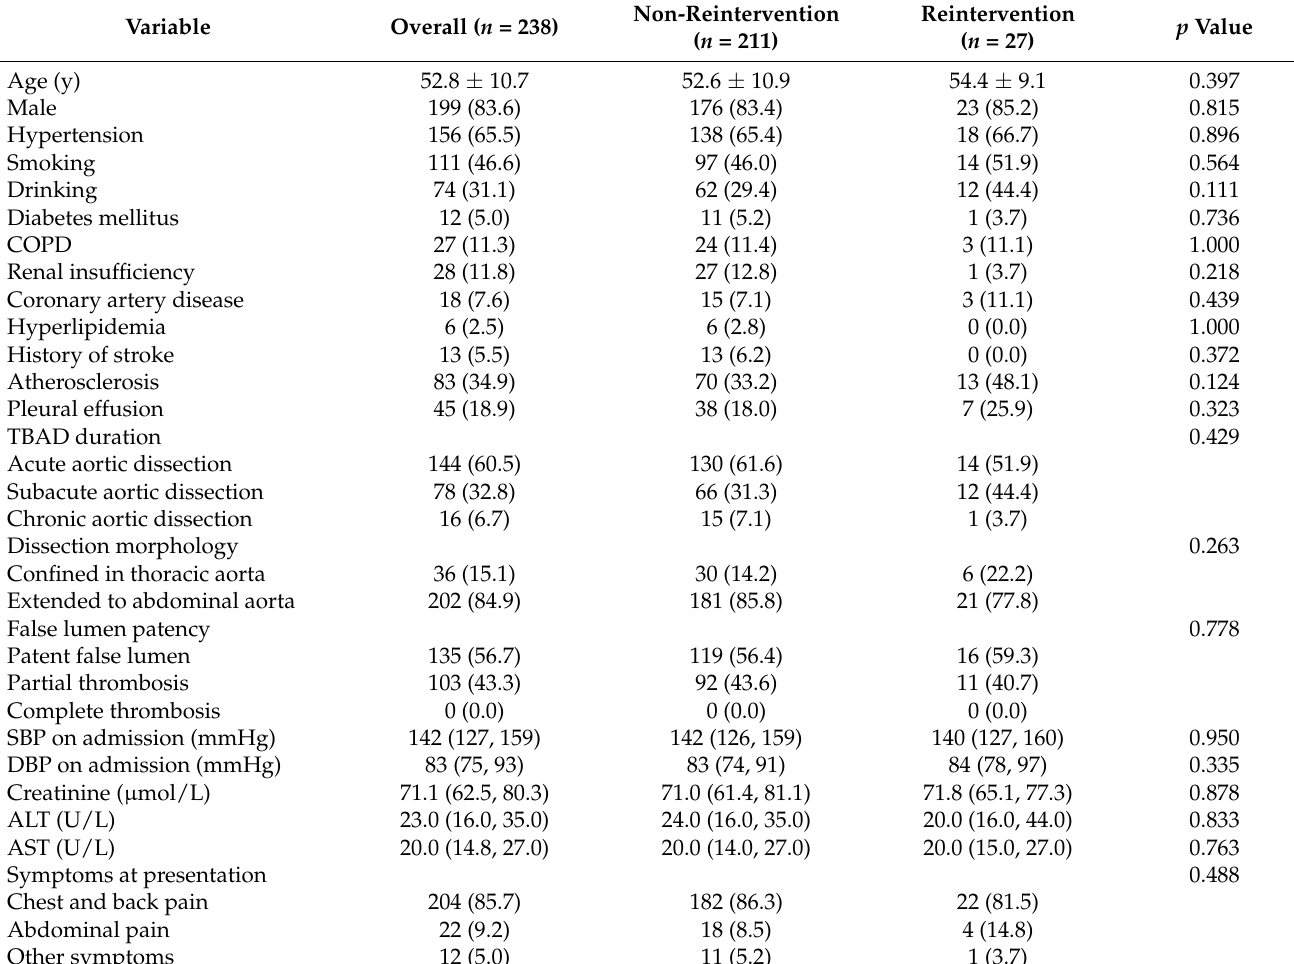
Table 1. Baseline covariate